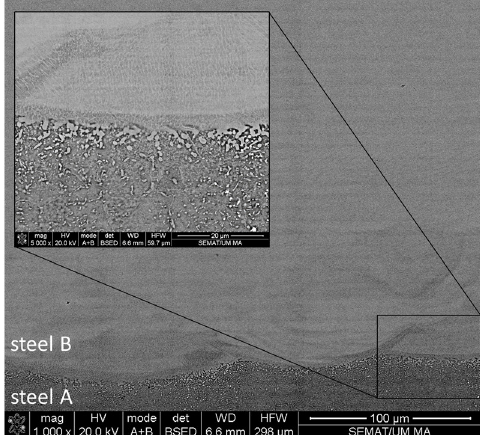
Figure 6. SEM image of the transition zone in the A.B. bonded configuration.